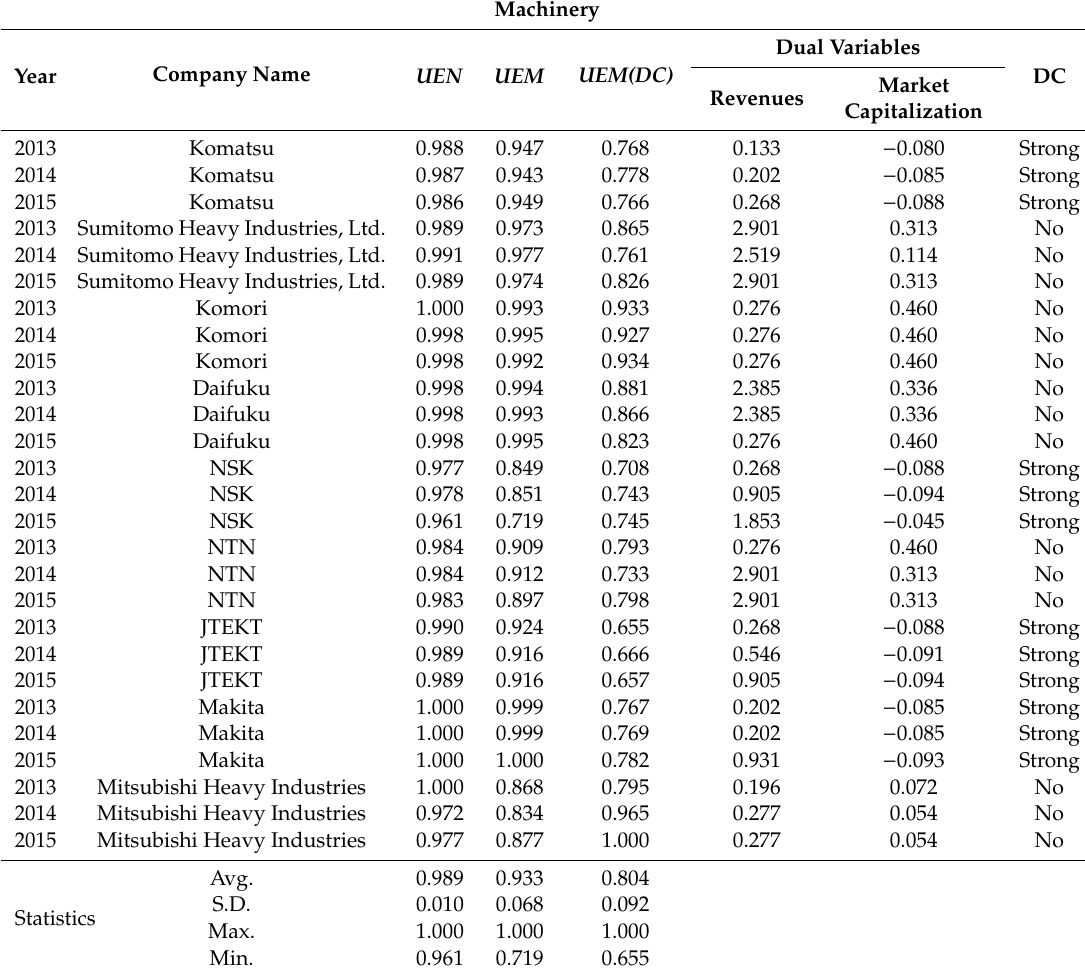
Table 3. Unified e ffi ciencies on machinery